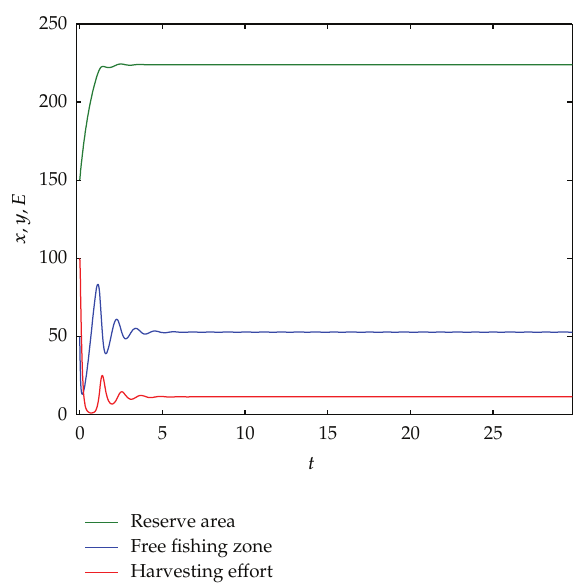
Figure 1: Solution curves corresponding to the tax τ δ (cid:6) 15 . 1, beginning with x (cid:6) 50, y (cid:6) 150, and E (cid:6) 100.